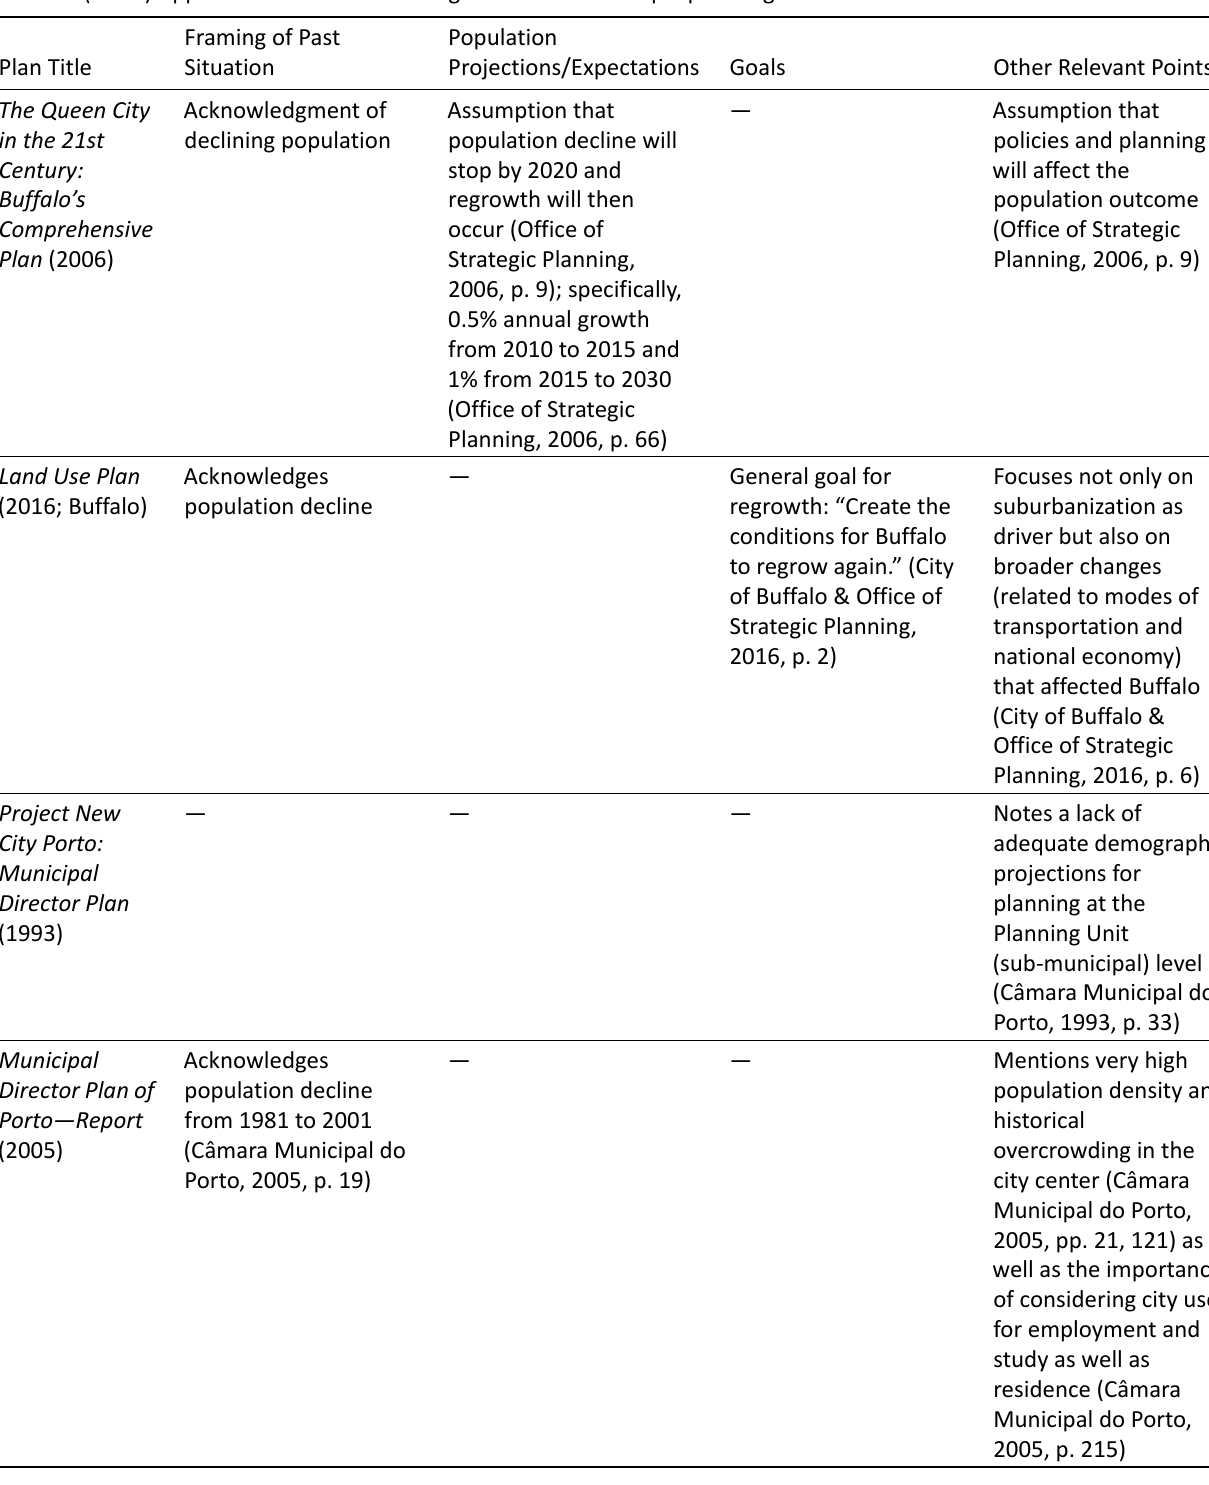
Table 2. (Cont.) Approaches to urban shrinkage as seen in municipal planning documents from Buffalo and